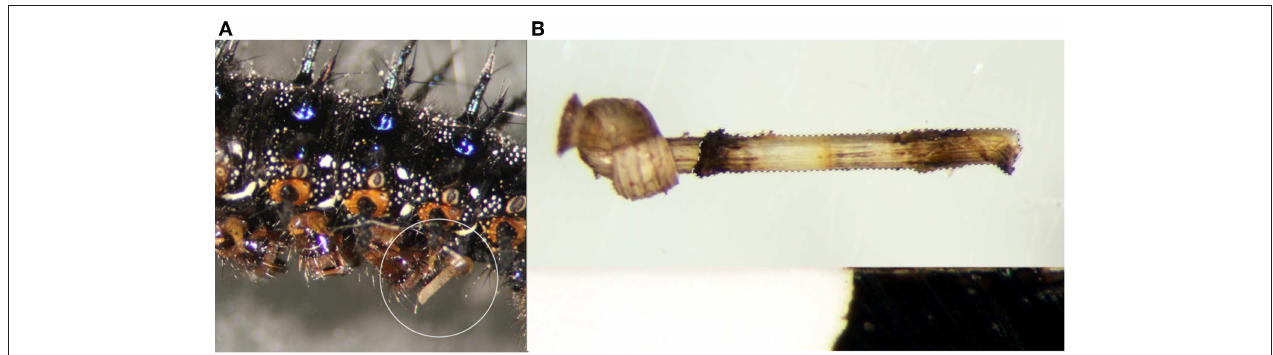
FIGURE 1 | Nylon filaments were inserted just beneath the cuticle (A) behind the 4th abdominal proleg and imaged after 24h (B) to measure the degree of melanization. Hashed lines represent the area of filament within the body of the caterpillar that was quantified.